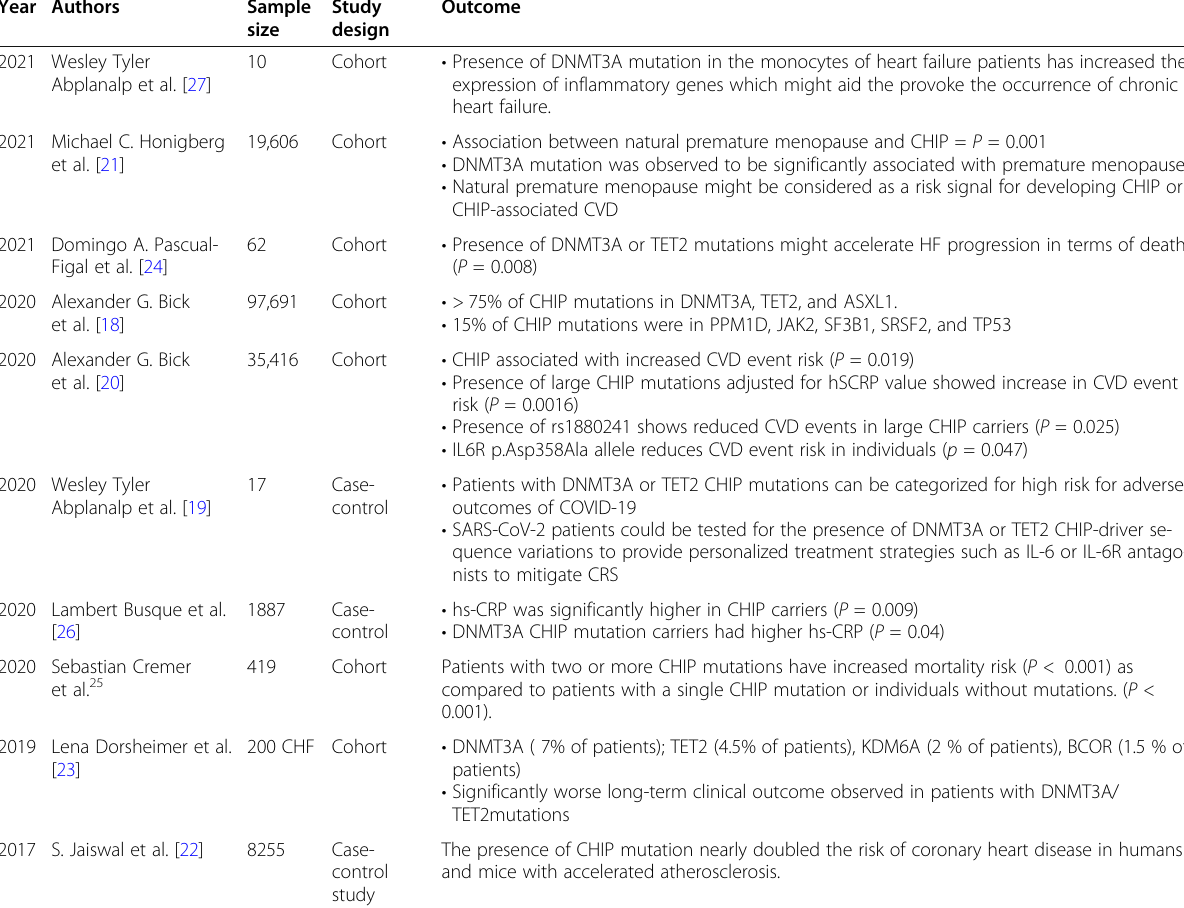
Table 2 Descriptive data of original articles reviewed Year Authors Sample